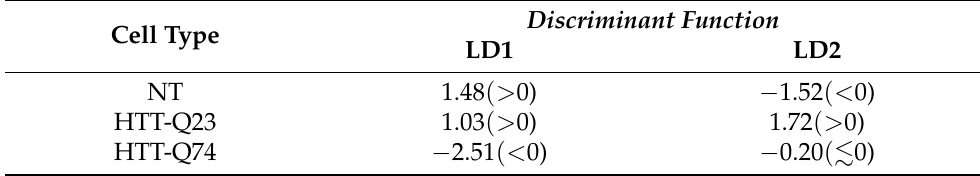
Table 1. Centroids of the discriminant functions for the three types of cell cultures.